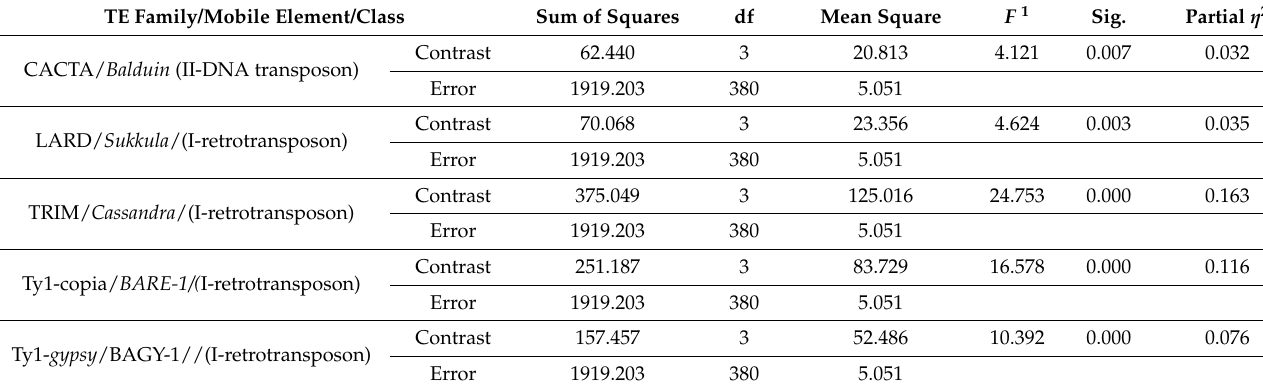
Table 3. The arrangement of simple main effects describing differences in mean sequence variation scores of the regenerant groups, derived from four donor plants by TE families evaluated based on univariate